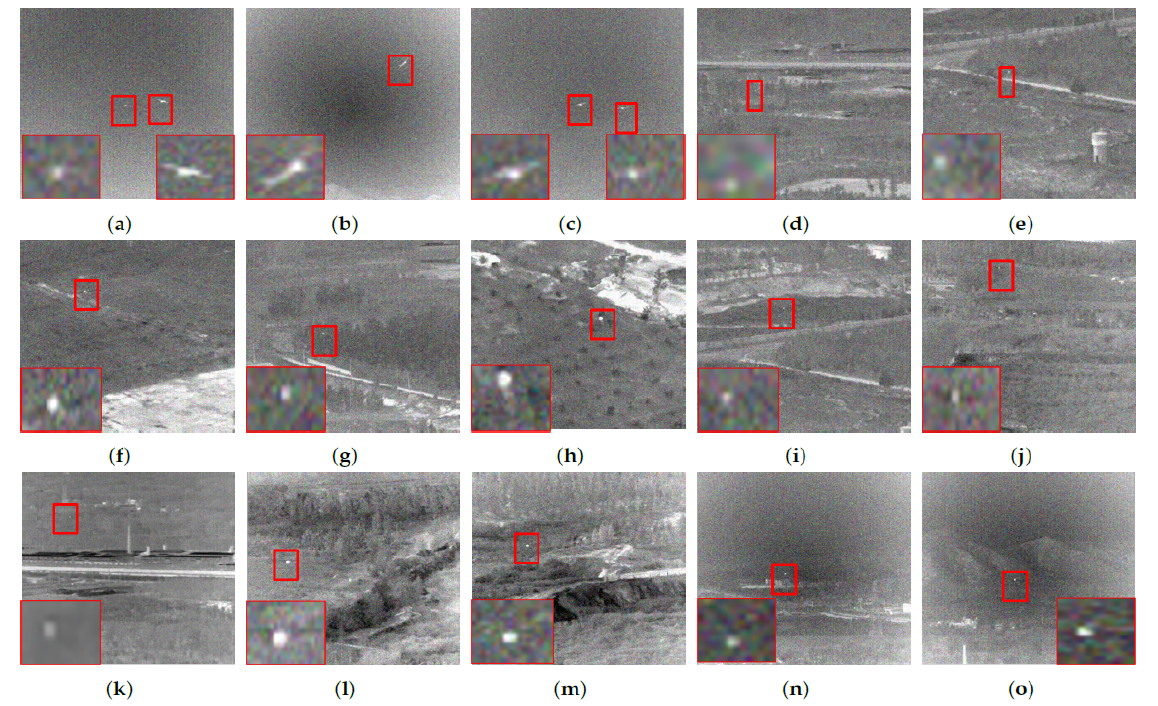
Figure 18. The original images added noise with mean 0 and variance 0.005. ( a – o ) represent the corresponding scenes in Figure 10.